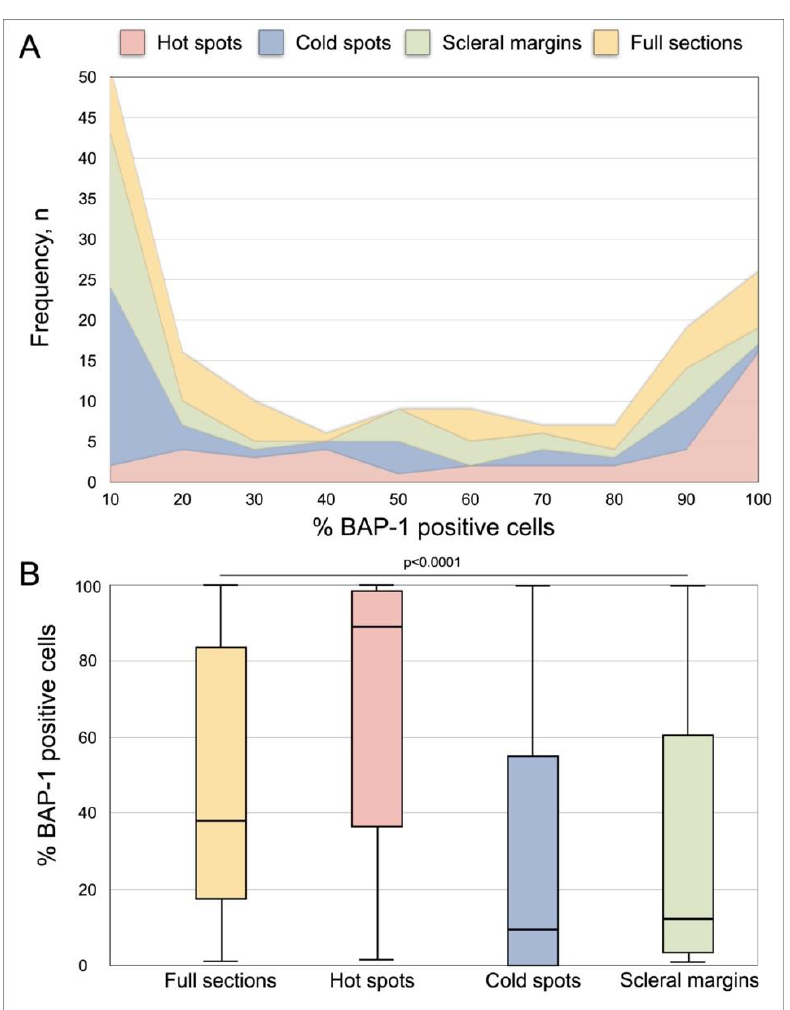
Figure 3. Distribution of the proportion of BAP-1 positive tumor cells in full tumor sections, hot spots, cold spots and scleral margins. ( A ) Cumulative frequency polygon. ( B ) Box plots. The mean proportion of BAP-1 positive cells was significantly different in full sections, hot spots, cold spots and scleral margins (one-way ANOVA p < 0.0001). Error bars represent 95% confidence interval.